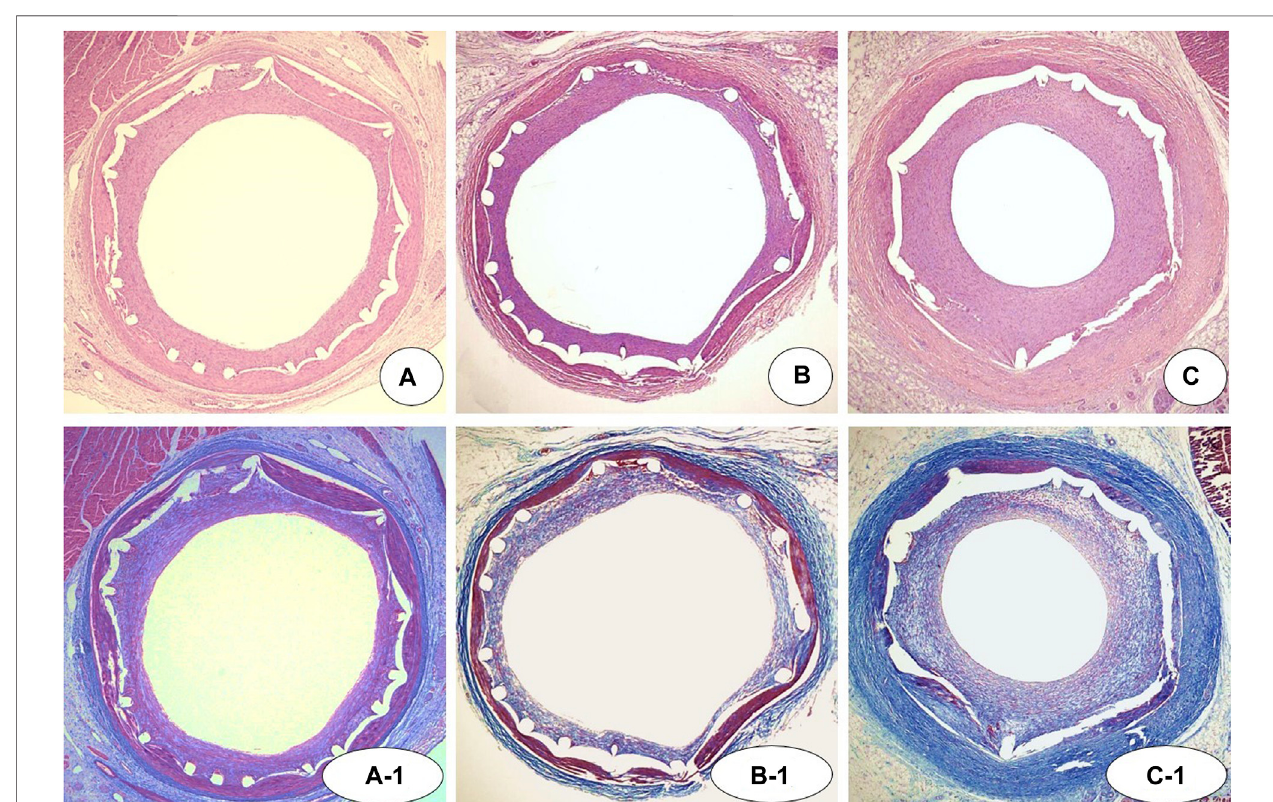
FIGURE5| Representativeimagesofhematoxylin-eosin[ (A – C) × 20)andCarstairs ’ fi brinstaining(A-1,B-1,andC-1, × 20)at4 weeksafterstenting.Specimensof implanted NTM [ (A) and A-1], EES [ (B) and B-1], and NT [ (C) and C-1]. NTM, TiO 2 fi lm – coated stent with mycophenolic acid; EES, everolimus-eluting stent with biodegradable polymer; NT, TiO 2 fi lm – coated